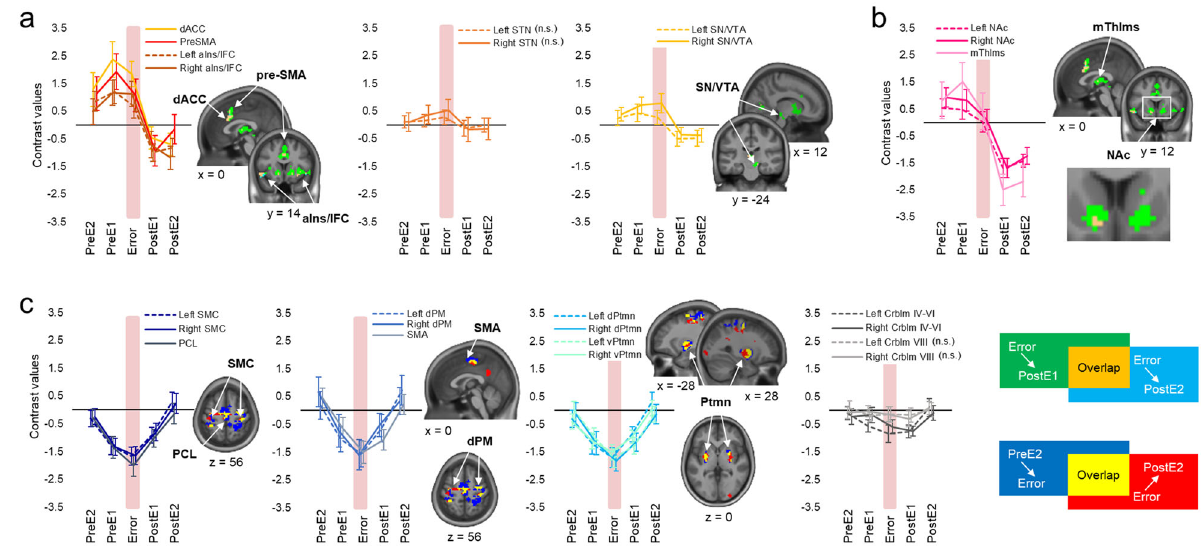
Fig. 5 Temporal characteristics of changes in activity during error processing. Areas with a increased activity during errors, b decreased activity during post-error trials, and c decreased activity during errors, respectively. Activity levels are estimated relative to the control error-free task condition. The results of the whole-brain analyses, thresholded at p < 0.001 (signi fi cant peaks and statistics are summarized in Table 2), are shown as colored clusters: green and cyan — areas where activity levels signi fi cantly decrease by the fi rst and the second correct trial immediately after errors, respectively; blue — areas exhibiting decreased activity during error processing; red — areas where activity levels signi fi cantly increase with performance recovery. Data points represent mean change in activity (contrast values) for each ROI immediately before, during, and immediately after errors relative to the corresponding position-matched trials of the error-free condition (i.e., zero values along the x -axis); positive/negative values indicate activity increases/decreases during periods with errors relative to those without errors. Coordinates and statistics for each ROI are reported in Table 3. n.s. - no signi fi cant effect. dACC - dorsal anterior cingulate cortex, pre-SMA - pre-supplementary motor area, aIns/IFC - anterior insula/inferior frontal cortex, STN - subthalamic nucleus, SN/VTA - substantia nigra/ventral tegmental area complex, NAc - nucleus accumbens, mThlms - midline thalamic nuclei, SMC - sensorimotor cortex, PCL - paracentral lobule, dPM - dorsal premotor cortex, SMA - supplementary motor area, d/vPtmn - dorsal/ventral putamen, Crblm - cerebellum. PreE2 and PreE1 — two consecutive sequences immediately before the error, PostE1 and PostE2 — two consecutive sequences immediately after the error. Error bars represent standard error of the mean